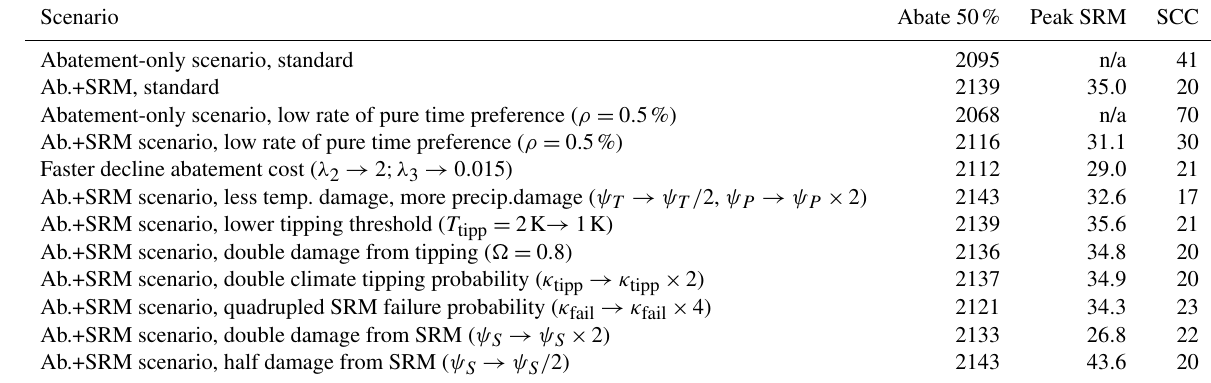
Table 4. Policy metrics of the sensitivity runs. “Abate 50%” is the year in which abatement reaches 50% ( µ = 0 . 5). “Peak SRM” (in Mt(S)yr − 1 ) is the highest SRM value of the ensemble (over all times and all members) and corresponds to those ensemble members without early SRM failure or climate tipping. “SCC” is the social cost of carbon in USD(2005) per tonne of carbon. All simulations were preformed in the stochastic settings and are either abatement-only scenario or abatement+SRM scenario (abbreviated here as Ab.+SRM). The first two cases, labelled “standard”, are repeated from Table 3 for convenience. The sensitivity runs correspond to those discussed in Sect. 3.5. n/a means not